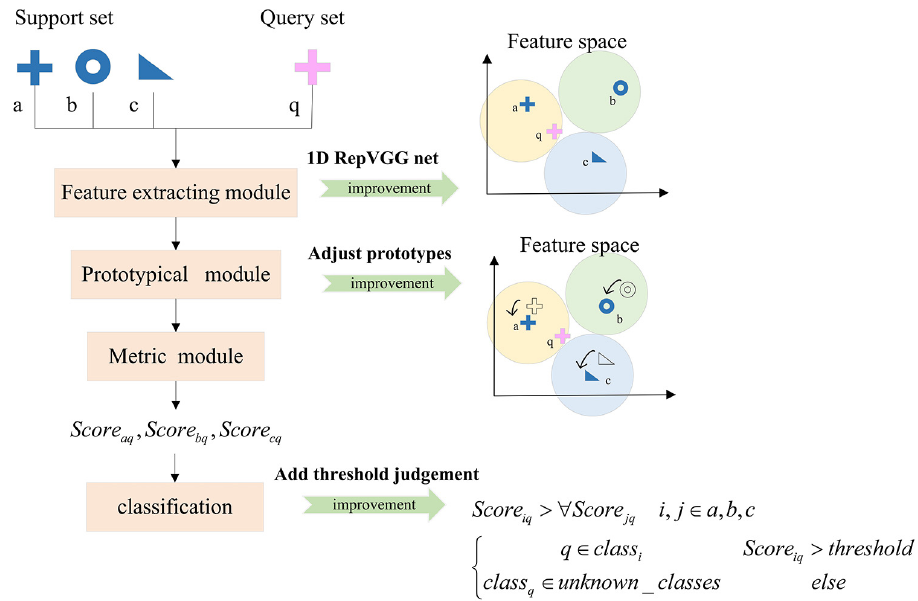
Figure 4. Processing flow and